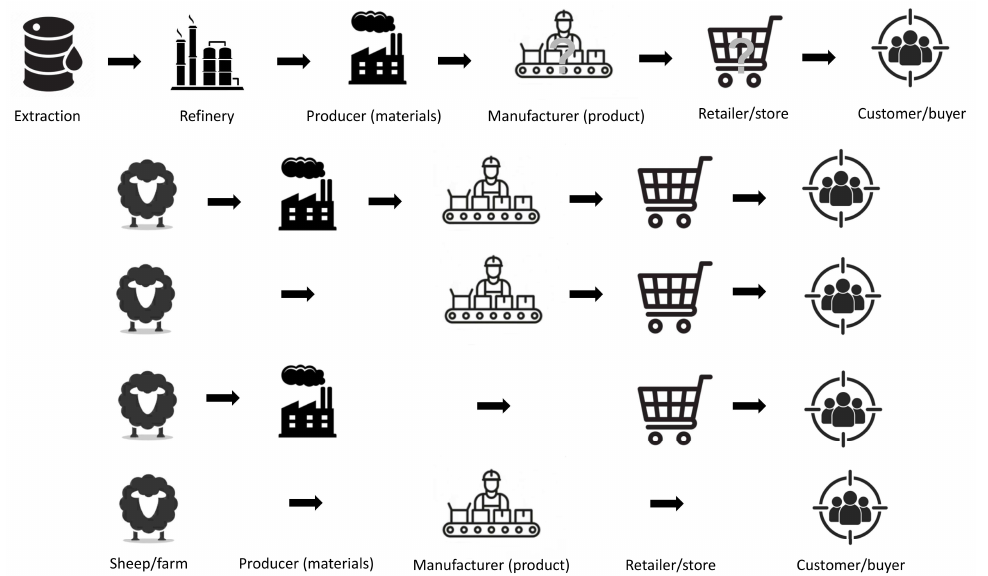
Figure 5. Illustration of value chains for synthetic products and the examined wool products (photos: